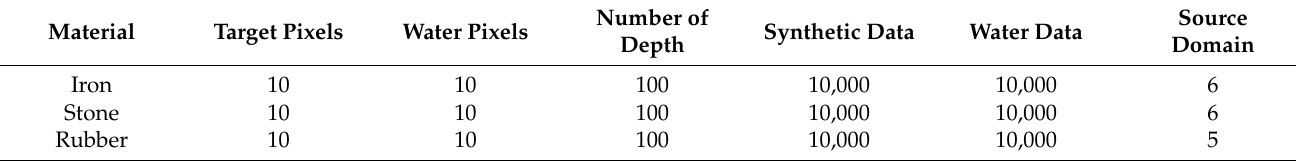
Table 1. Target detection network training dataset parameters.